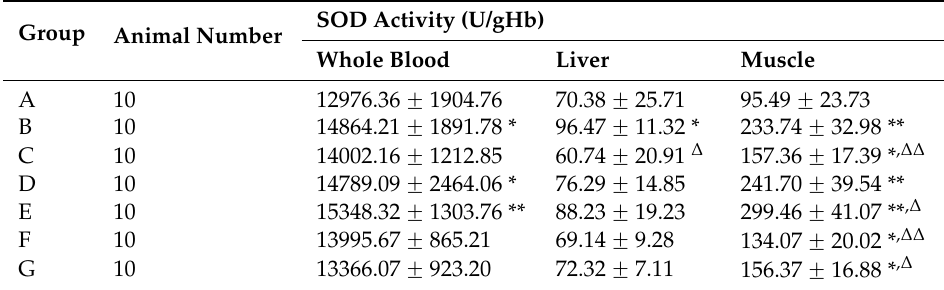
Table 7. Fe-HPH II chelate and superoxide dismutase (SOD) activity in rat blood, liver, and muscle. SOD Activity (U/gHb) Group Animal Number Whole Blood Liver Muscle